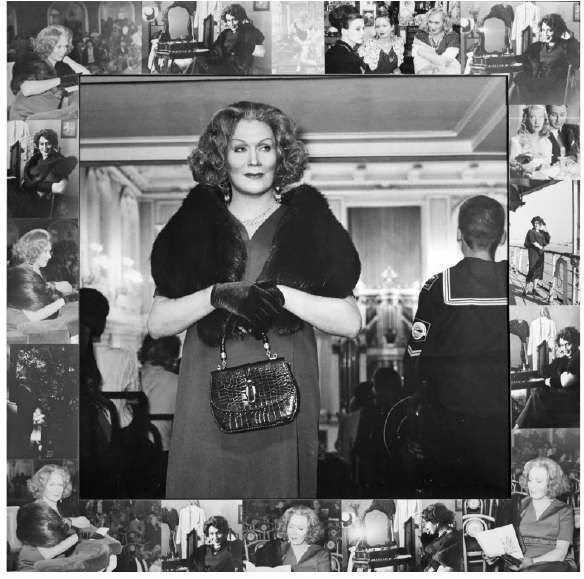
Figure 12. Vlad Mamyshev-Monroe. From the series “Happy Love (Liubov’ Orlova)” (2000); https: